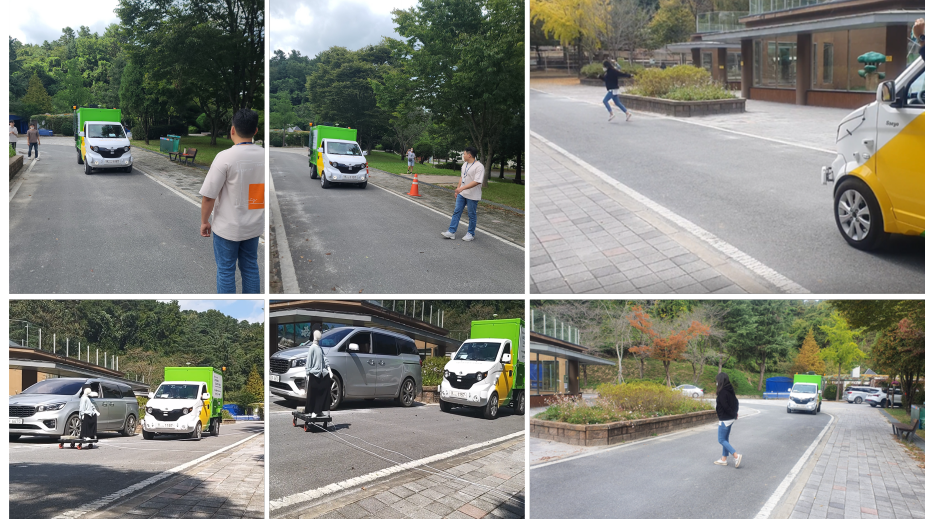
Figure 24. Human recognition